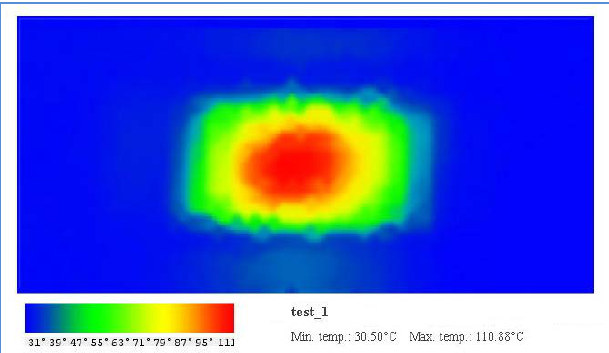
Figure 7. Obtained thermal image from